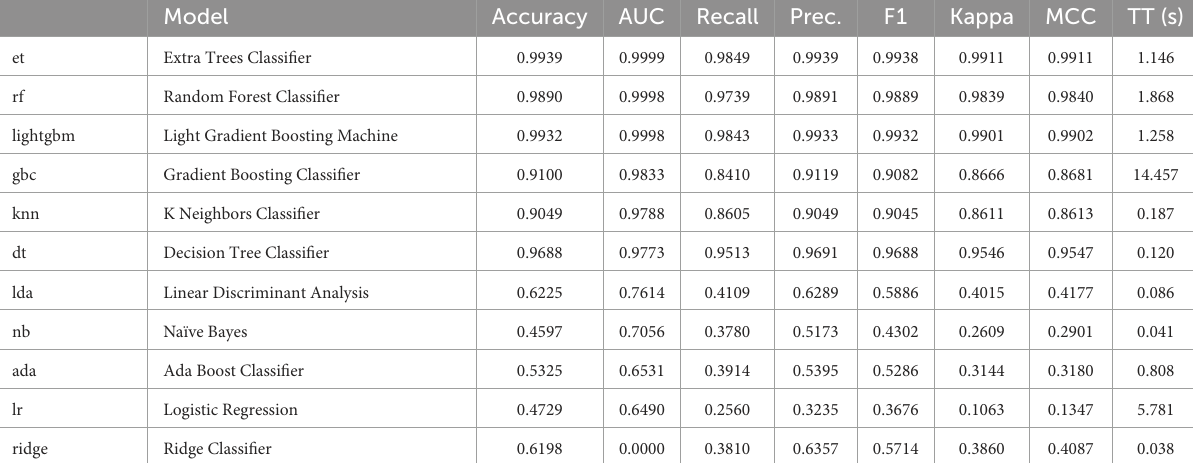
TABLE 3 The performance of machine learning algorithm